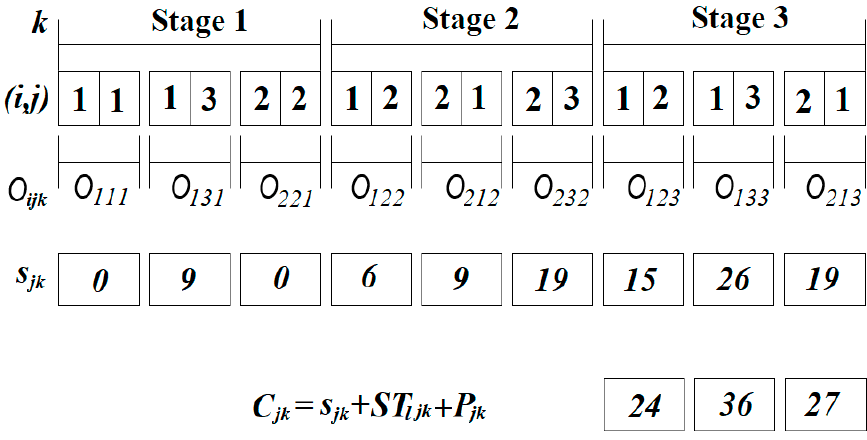
Figure 5. Symbolic representation for an HGAG individual. Selection